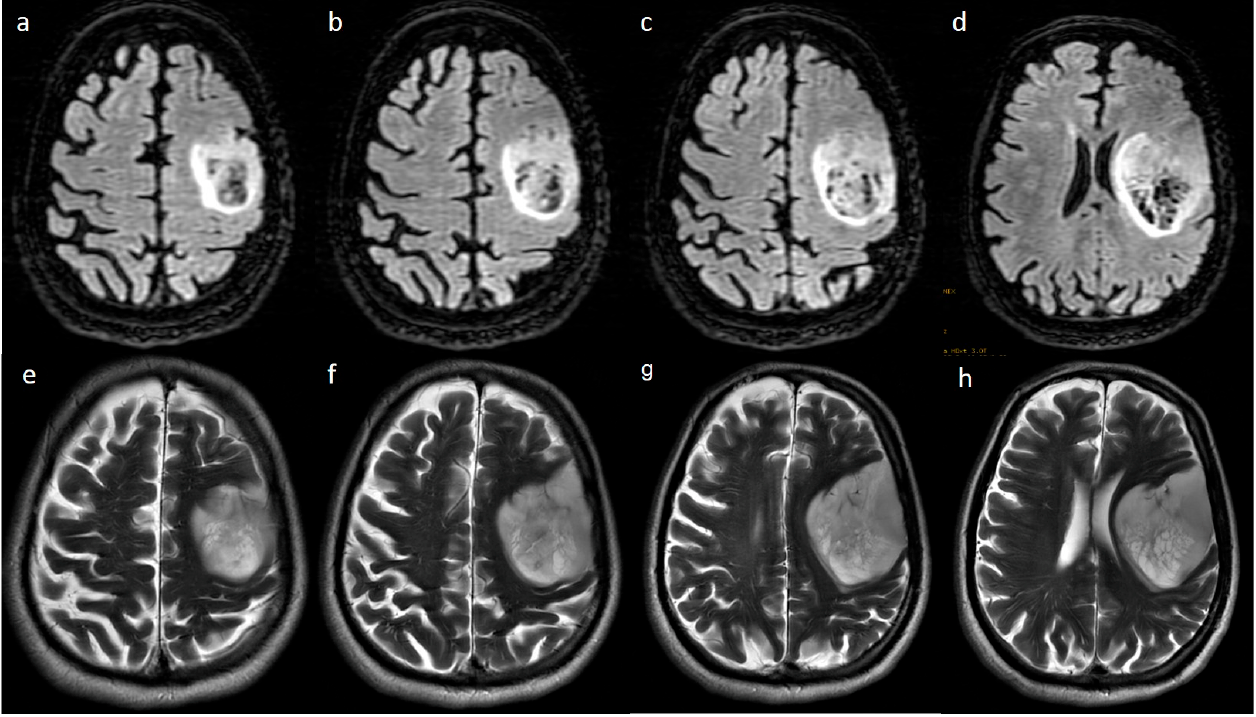
Figure 6. ( a – c ) Representative axial FLAIR and coronal T2w images show a tumor with a broad base towards the cortex with subcortical involvement.